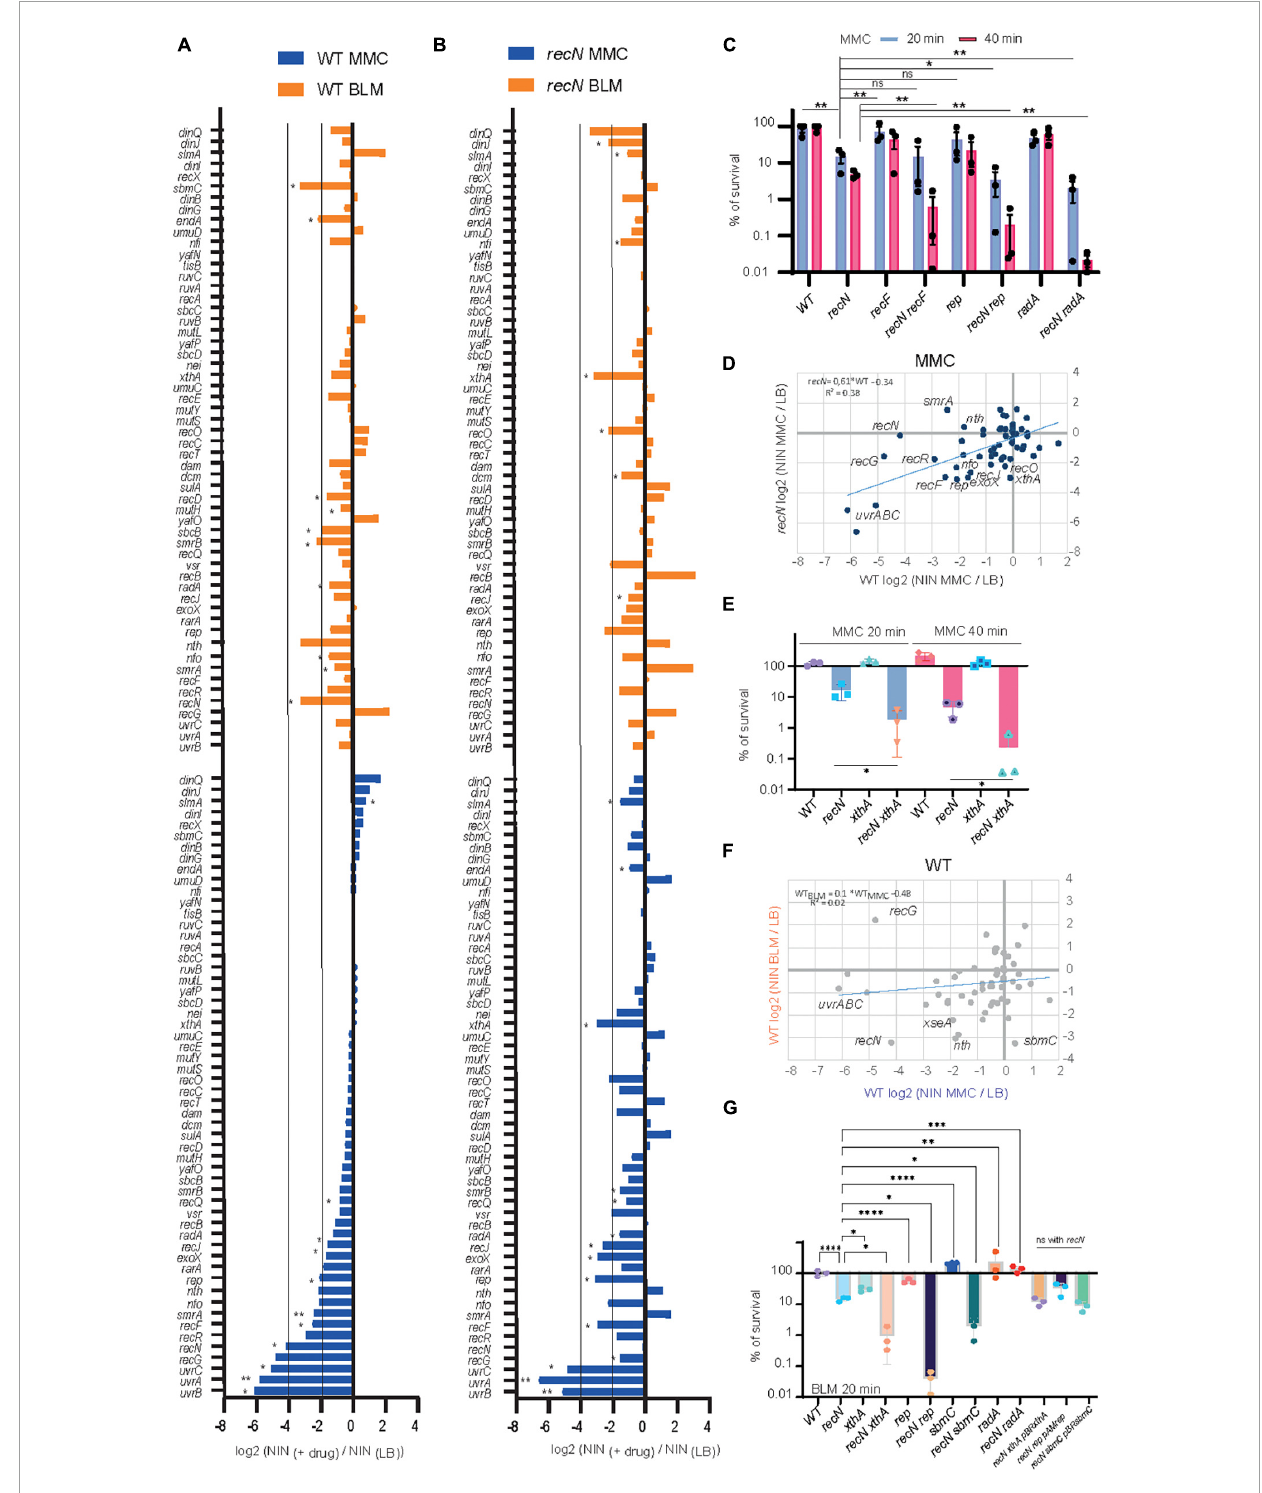
FIGURE4 Transposon-insertion sequencing (TIS) analysis of the DDR genes involved in BLM and MMC tolerance. (A) TIS results in the presence of MMC or BLM for the subset of E. coli DDR genes in the WT strain. Results are average of three replicates and analyzed with multiple paired t -test * < 0.1; ** < 0.05 (B) same as A for the recN strain. (C) CFU analysis of the WT, recN , recF , rep , and radA single and double mutants in the presence of MMC. Anova statistical test * < 0.05, ** < 0.005 (D) comparison of the TIS results in MMC for the WT (Log2 FC MMC − WT ) and recN strain (Log2 FC MMC − recN ). (E) CFU analysis of the WT, recN , xthA , and recN xthA mutants in the presence of MMC. Anova statistical test * < 0.05. (F) Comparison of the TIS results in WT strain in MMC (Log2 FC MMC − WT ) and BLM (Log2 FC BLM − wt ). (G) CFU analysis of the WT, recN , xthA , recN xthA , rep , recN rep , sbmC , recN sbmC , radA , and recN radA mutants in the presence of MMC. To reveal additive effects of the double mutants BLM at 0.5 µ g/ml for 20 min was used. Anova statistical test ∗ < 0.05, ∗∗ < 0.005, ∗∗∗ < 0.0005, ∗∗∗∗ <